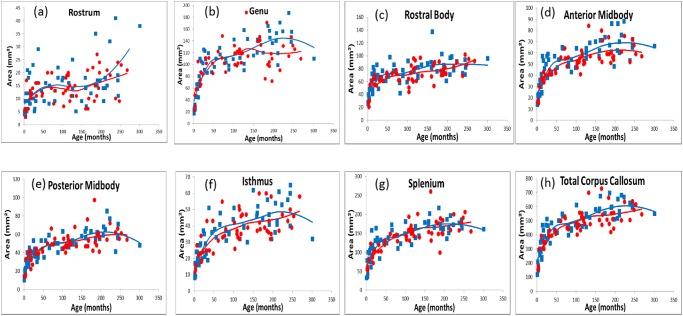
Scatter plots by monthly age and sex of absolute area of the each part of corpus callosum with local smoothing models (LOESS).(a); rostrum, (b) genu, (c) rostral body, (d) anterior midbody, (e) posterior midbody, (f) isthmus, (g) splenium, (h) total corpus callosum, blue square: male (n = 61), red circle: female (n = 53), blue line: males’ LOESS, red line: females’ LOESS.